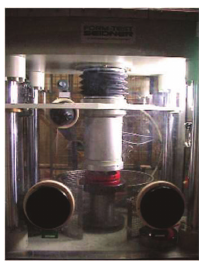
Fig. 16. Mechanical resistance measurements.